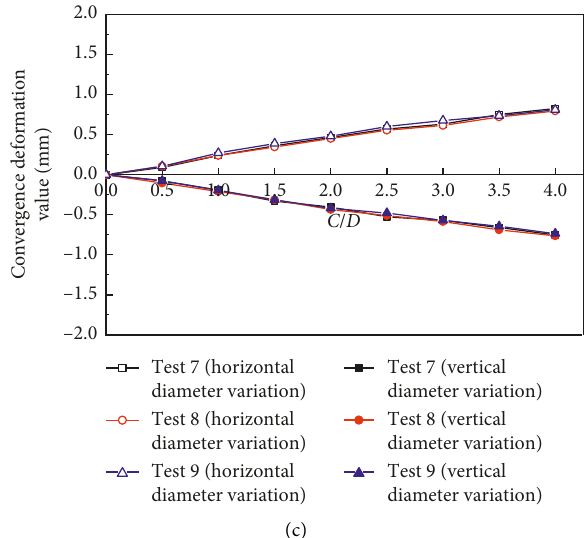
Figure 13: Variations in the vertical and horizontal diameters of the ninth ring with increasing load for nine tests under the realistic loading conditions. (a) Straight-jointed ring. (b) Stagger-jointed ring. (c) Uniform ring.